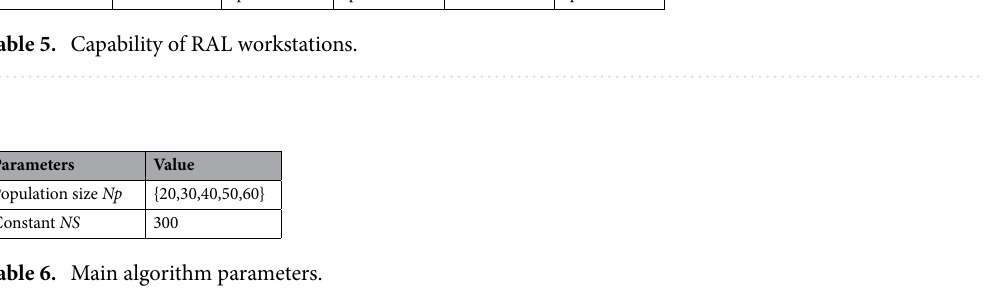
Table 6. Main algorithm